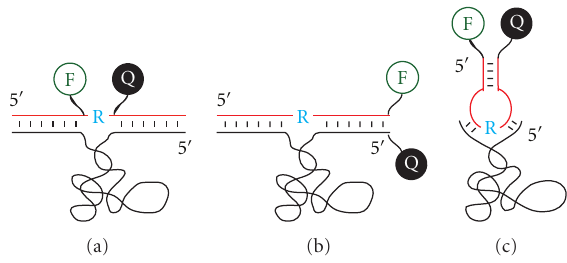
Figure 4: Three common arrangements of fluorophore (F) and quencher (Q) in the design of fluorescent RNase DNAzyme-based biosensors. F and Q are appended to the nucleobases that flank the cleavage site (a), placed at the end of duplex formed between the substrate and DNAzyme strands (b), or located at the end of the hairpin-shaped substrate strand (c). DNAzyme and substrate strands are shown in black and red, respectively. The cleavage site is marked by a blue